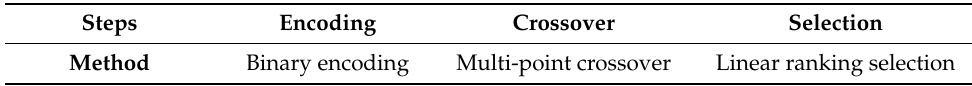
Table 2. Methods choices of genetic algorithm.